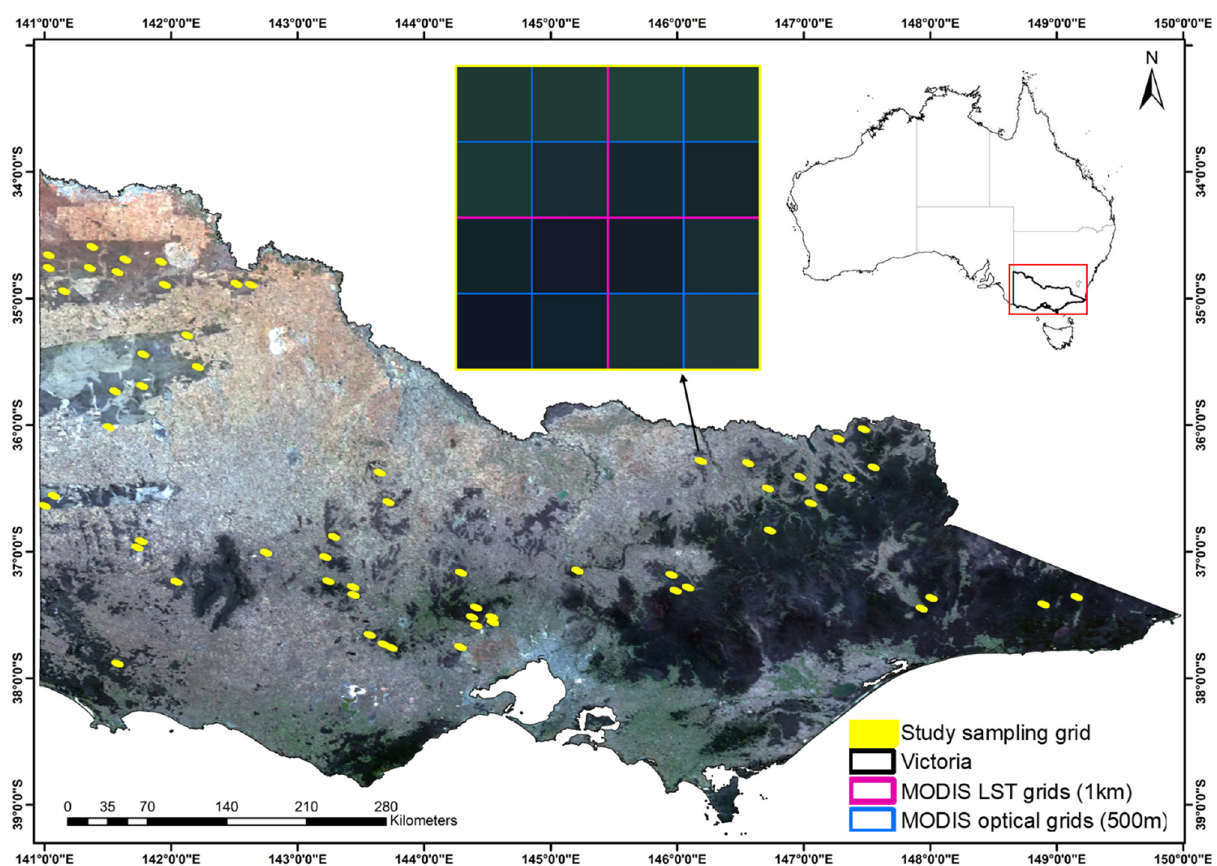
Figure 2. Study area and spatial locations of the sixty sampling windows, the image shown is the RGB image created using MODIS-MCD43A4 dataset (image and sixty sampling windows are shown in WGS 1984 projection, while the highlighted grid has Sinusoidal projection as used by MODIS datasets).